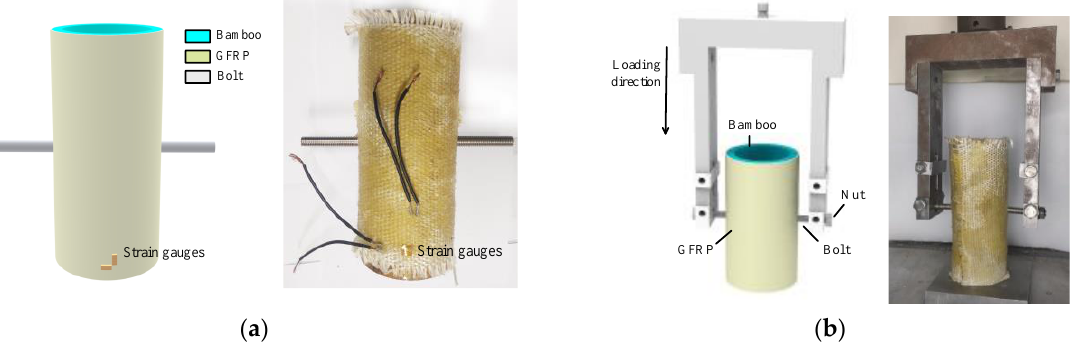
Figure 7. Position of the strain gauges and the loading method. ( a ) Position of strain gauges; ( b ) Loading method of composite joint.